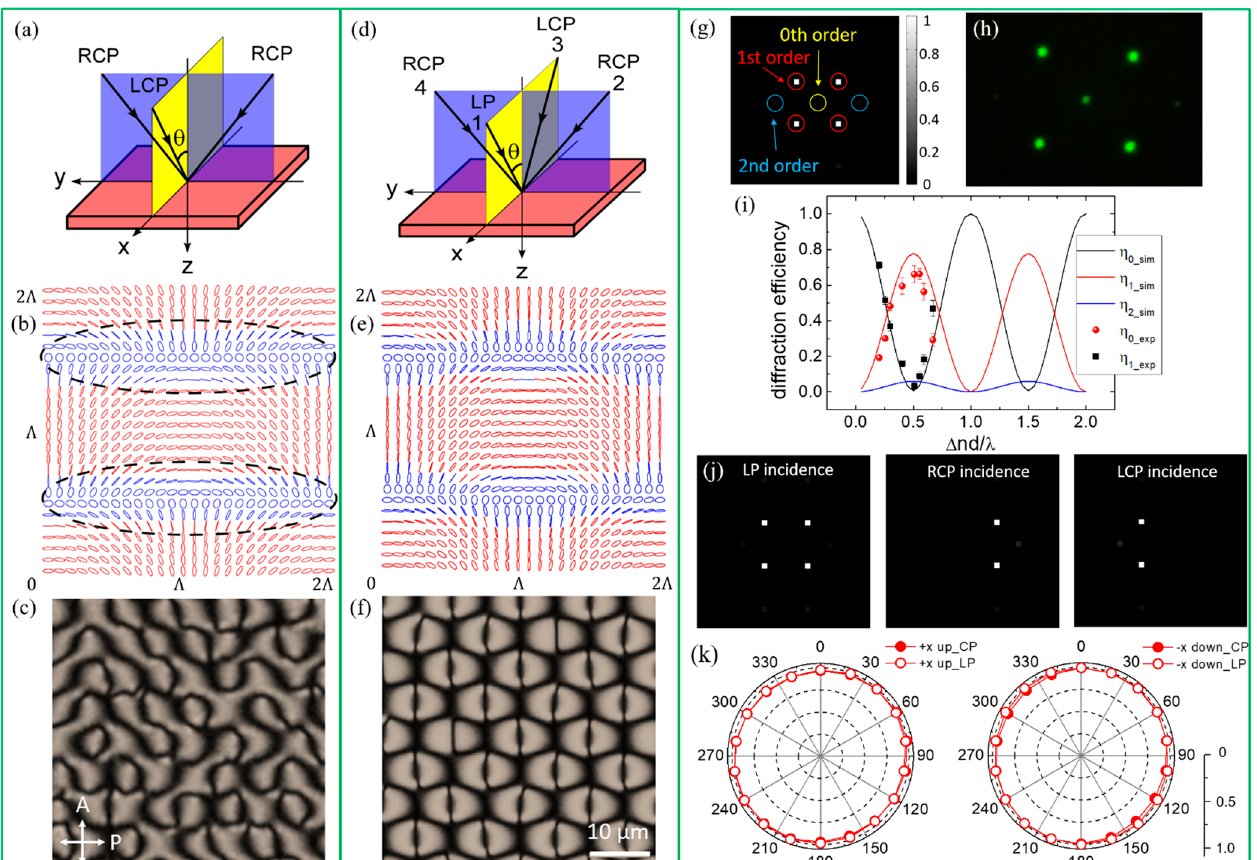
Figure 11. ( a ) Arrangement of three interference beams. ( b ) Simulated polarization pattern of the interference field. ( c ) LC texture observed by POM. ( d ) Arrangement of the interference by introducing a LP beam. ( e ) Simulated polarization pattern of the interference field when the LP light intensity is 1/5 of each CP light (valid throughout the figure). ( f ) LC texture of the fabricated 2D PG observed by POM. ( g ) Simulated diffraction pattern at the half-wave conditions. ( h ) Diffraction pattern of the 2D LC PG from the experiment. ( i ) Diffraction efficiency as a function of LC phase retardation. Lines: Simulation results; Scattered dots: Experiment results. ( j ) Polarization selectivity of the 2D LC PG diffraction based on the simulation. ( k ) Polar plot of the polarization measurements of the 1st-order diffractions. Reproduced with permission from Reference [53] © The Optical Society.